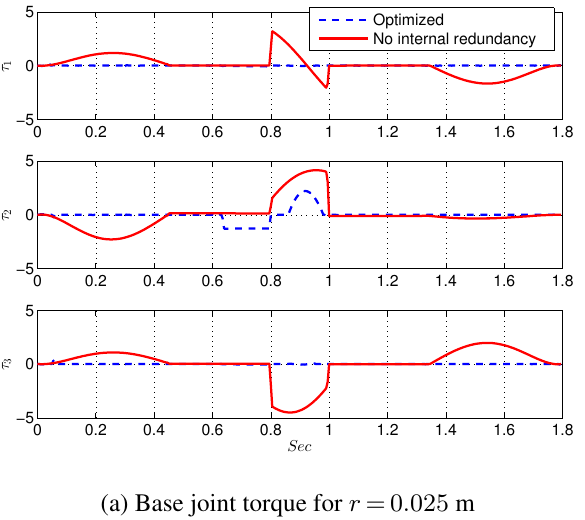
(b) Base joint torque for r = 0 . 013 m Figure 4. The torques of the ground actuators (in Nm) for λ = Fig. 4: The torques of the ground actuators (in N.m) for λ = 0 .